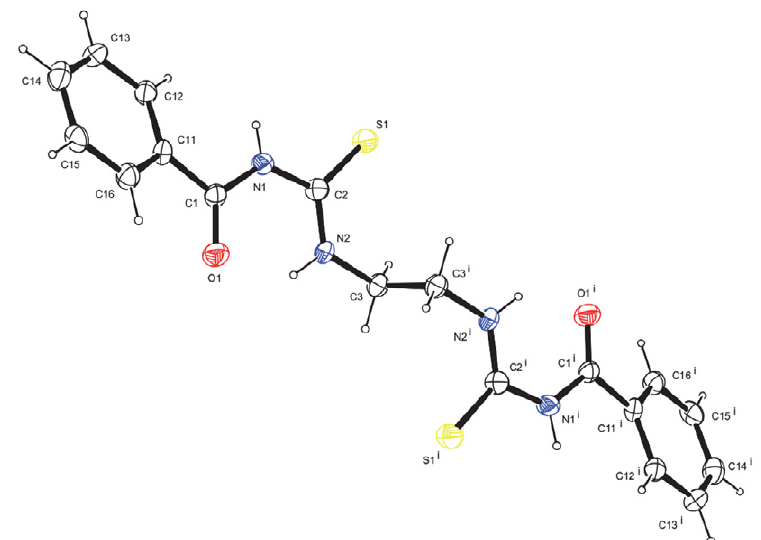
Figure 2. An ORTEP view of 3-benzoyl-1-(2-{[(phenylformamido)methanethioyl]amino}ethyl)thiourea ( 11 ) showing 50% probability displace- ment ellipsoids and the atom